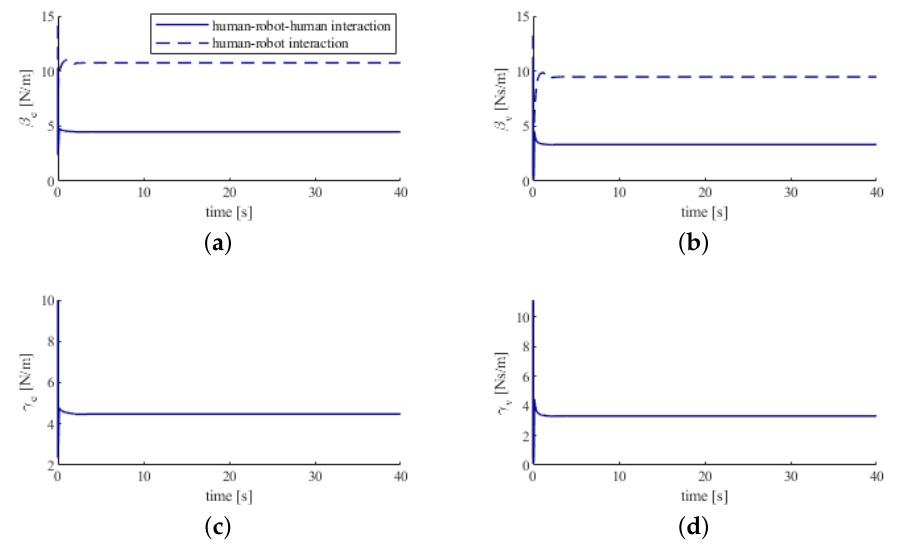
Figure 10. Humans’ control gains. The dashed lines correspond to the human-robot cooperative object transporting task. The solid lines correspond to the human-robot-human cooperative object transporting task. ( a ) the position error feedback gain of the human 1. ( b ) the velocity feedback gain of the human 1. ( c ) the position error feedback gain of the human 2. ( d ) the velocity feedback gain of the human